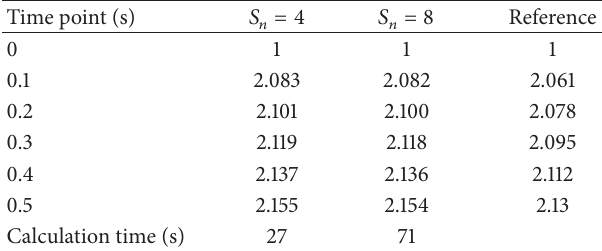
Table 3: Normalized power versus time with different discretization order in TWIGL problem during step